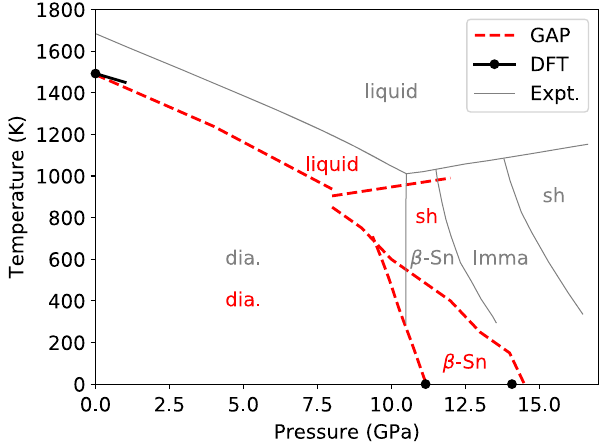
FIG. 10. Temperature-pressure phase diagram of silicon, com- puted with the GAP (red), compared to available DFT results (black) and experimental phase transitions (gray). The finite- temperature DFT value and slope are from Ref. [191], and the experimental lines are from Ref.